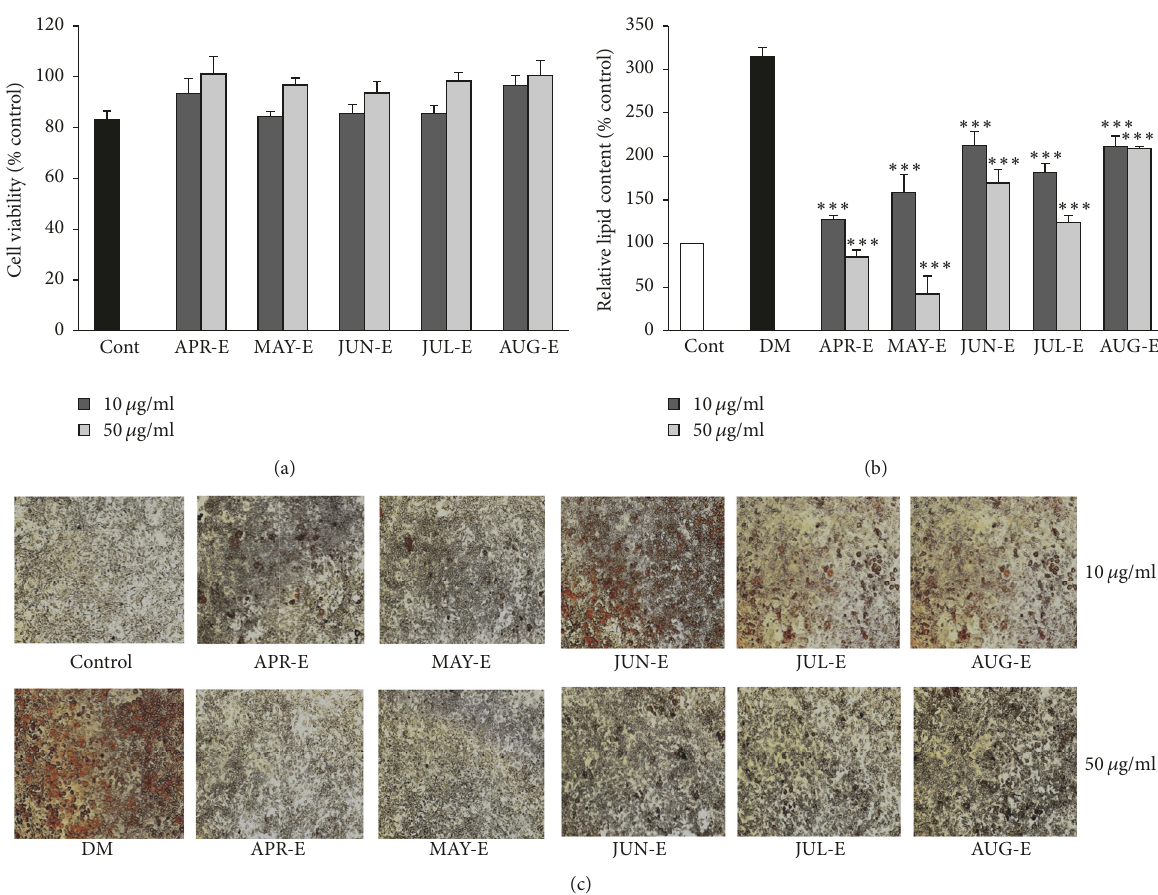
Figure 3: Antiadipogenesis effect on 3T3-L1of SV extracts from different harvesting times from Ulleung Island. (a) Effect of SV extracts on 3T3-L1 cell viability determined by MTS assay at 10 and 50 𝜇 g/ml for 24h; (b) relative lipid content quantified by absorbance in 3T3-L1 cells with or without SV extract at 10 and 50 𝜇 g/mL for 8 days; (c) Oil Red O staining of lipid droplets in 3T3-L1 cells treatment with or without SV extract at 10 and 50 𝜇 g/mL for 8 days. Results are presented mean ± SE. The asterisk indicates a significant difference compared to DM ( ∗∗∗ 𝑃 < 0.001 ).